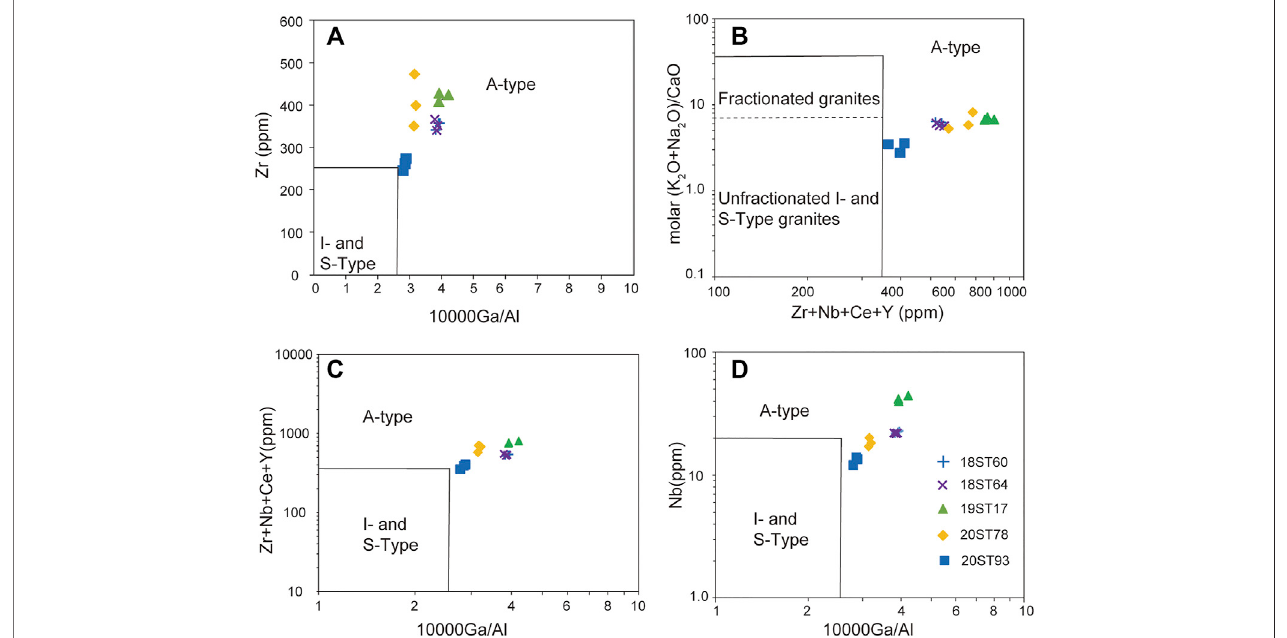
FIGURE10| Geneticdiscriminationdiagrams(afterWhalen etal.,1987)showingtheA-typeaf fi nityofthePermiangranitoidsinthisstudy. (A) Zrvs.10000 × Ga/Al diagram; (B) (K 2 O + Na 2 O)/CaO vs. (Zr + Nb + Ce + Y) diagram (C) (Zr + Nb + Ce + Y) vs. 10000 × Ga/Al diagram (D) Nb vs. 10000 × Ga/Al diagram.